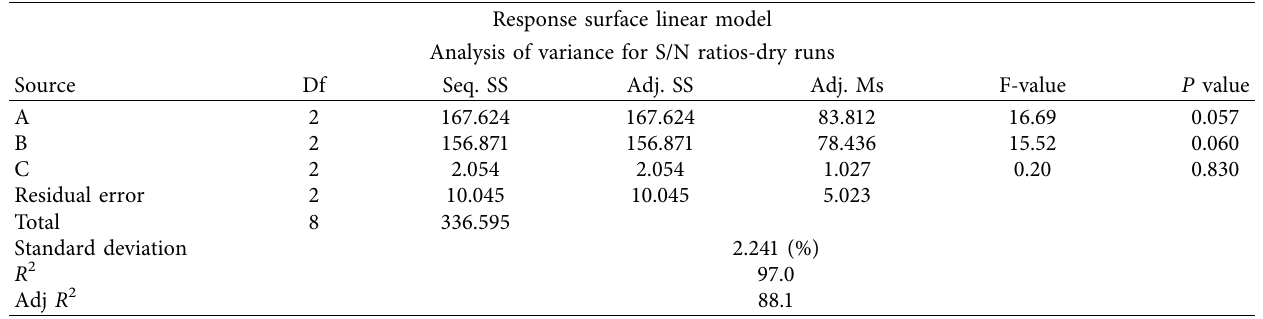
Table 7: ANOVA for S/N ratios (R